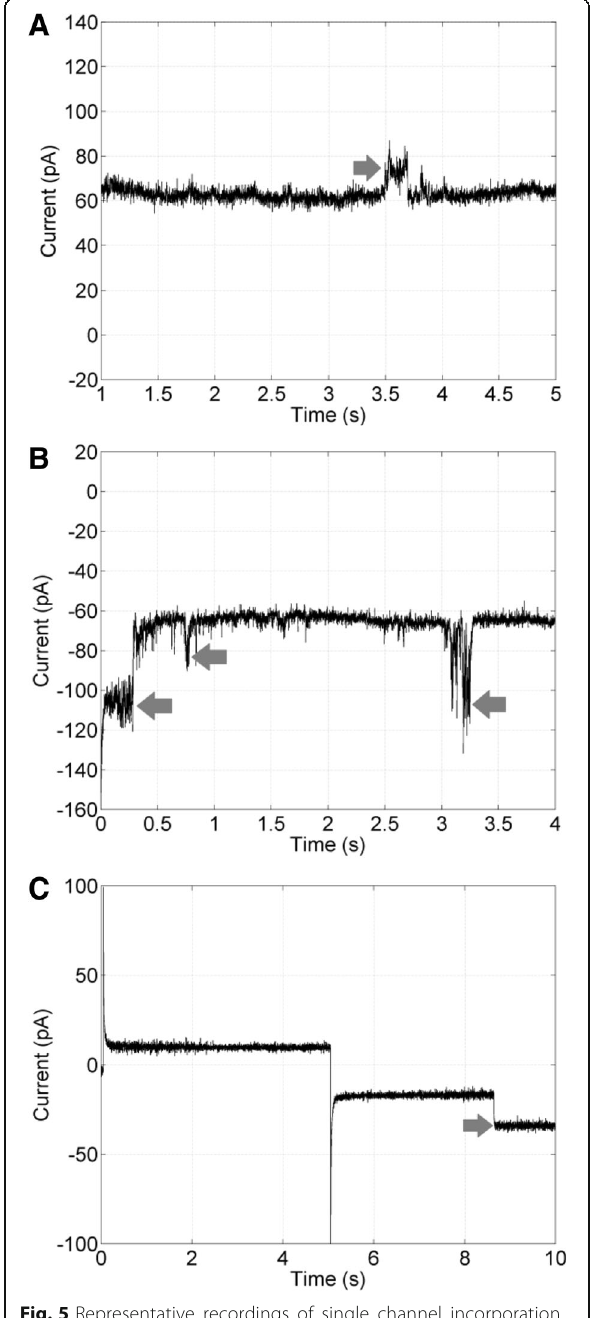
Fig. 5 Representative recordings of single channel incorporation in asolectin artificial lipid bilayers induced by xylopin at 1 μ M concentration. a Vhold = + 140 mV, pore conductances = 63 and 105 pS. b Vhold = − 140 mV, pore conductance = 143 and 259 pS. c Vhold was set at +100 mV for 5 s and was switched to − 100 mV for the remaining 5 s, pore conductance = 175 pS. Solutions: a and b 150 mM KCl, and c 500 mM KCl (symmetrical). Arrows indicate channel apertures or closings. Four independent experiments were